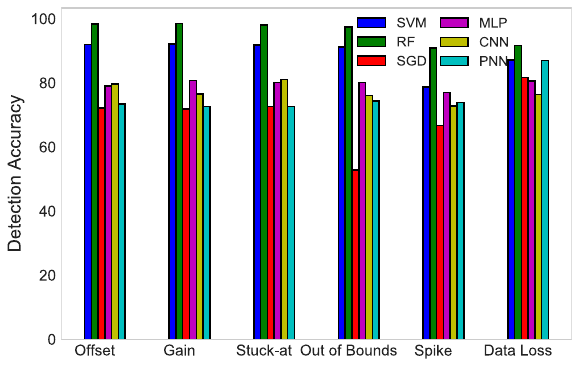
Figure 9. DA comparison of SVM, RF, SGD, MLP, CNN, and PNN detection of four types of fault.